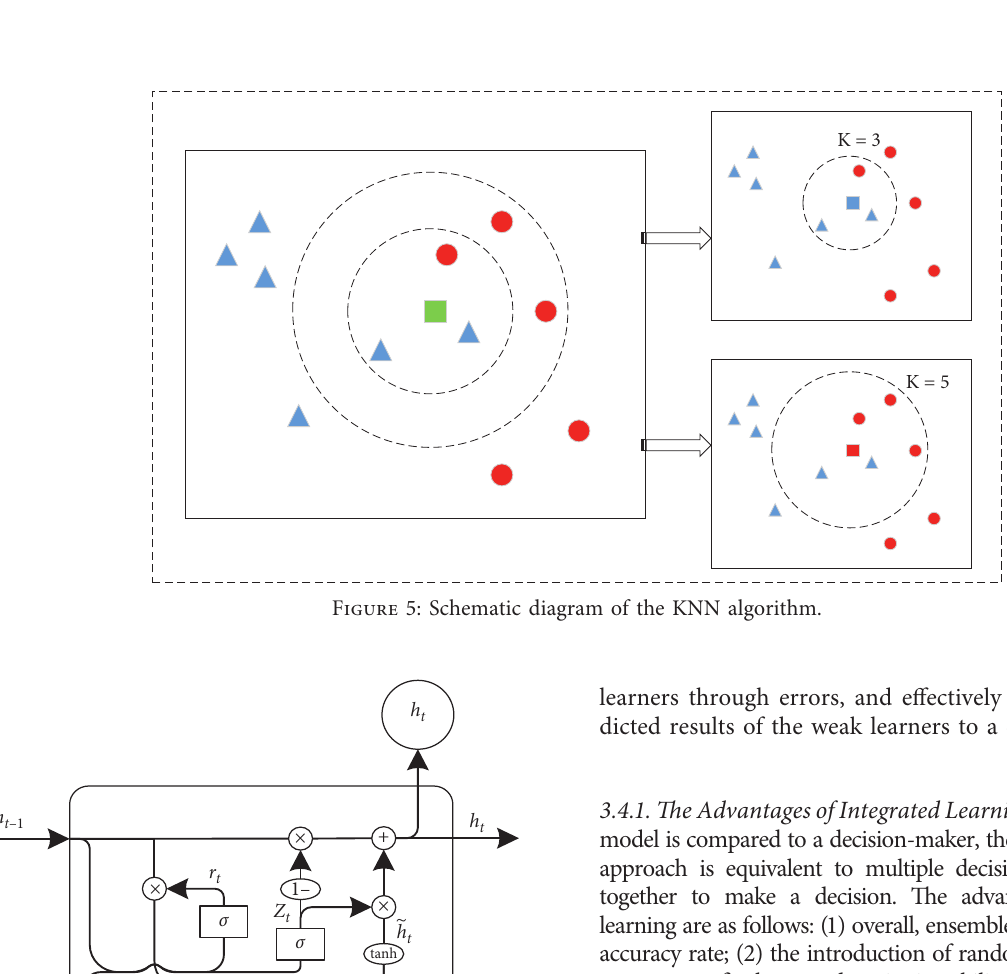
Figure 4: Schematic diagram of linear